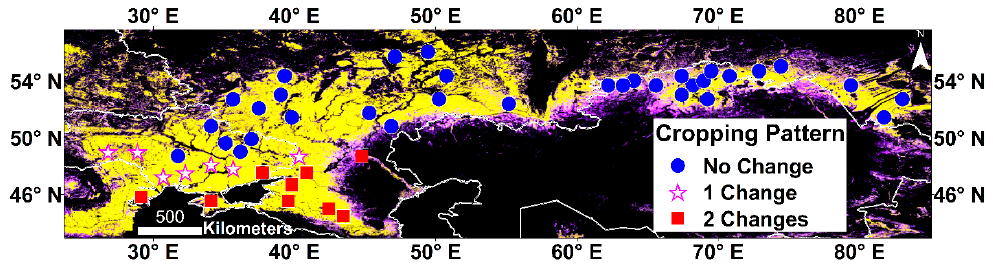
Figure 11. Changes in seasonal patterns by sites during 2003–2010: no change (blue circles), one change (white stars with pink borders), or two changes (red squares). Northern study sites displayed no change in seasonal pattern, while southern study sites experienced multiple changes.